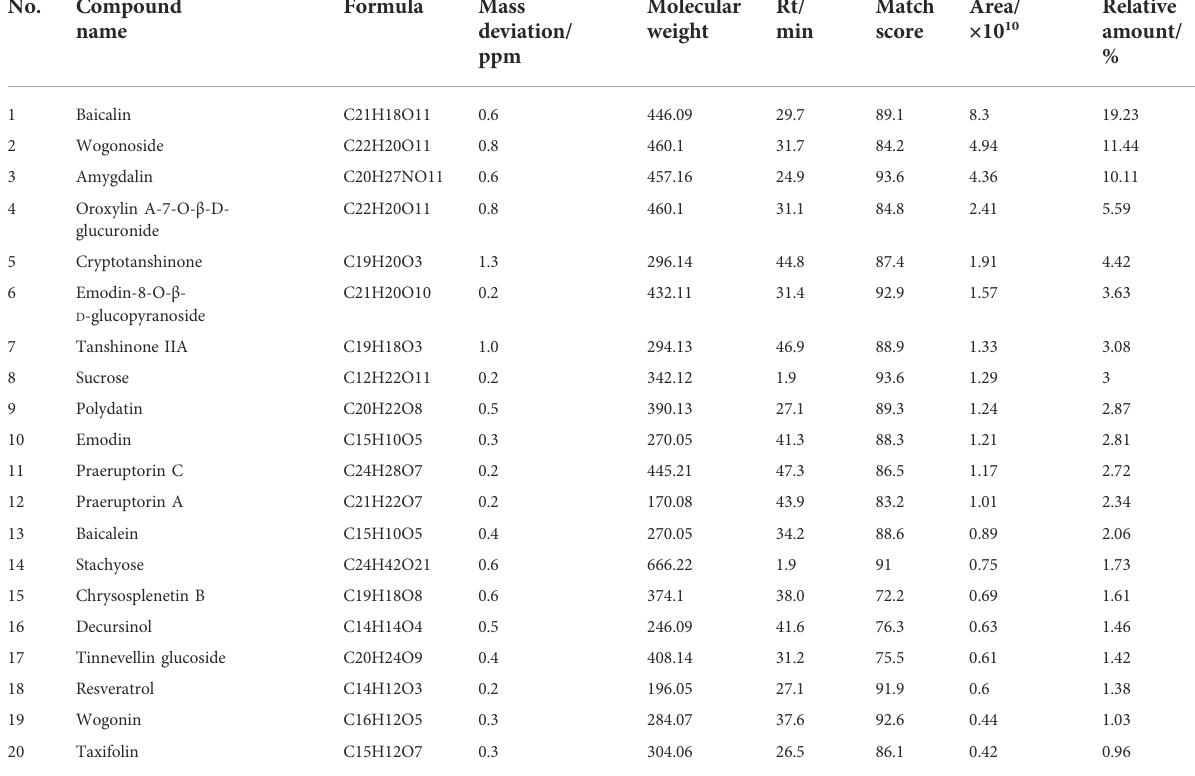
TABLE 2 The information of top 20 compounds of the extract of Qingfei oral liquid (QF).